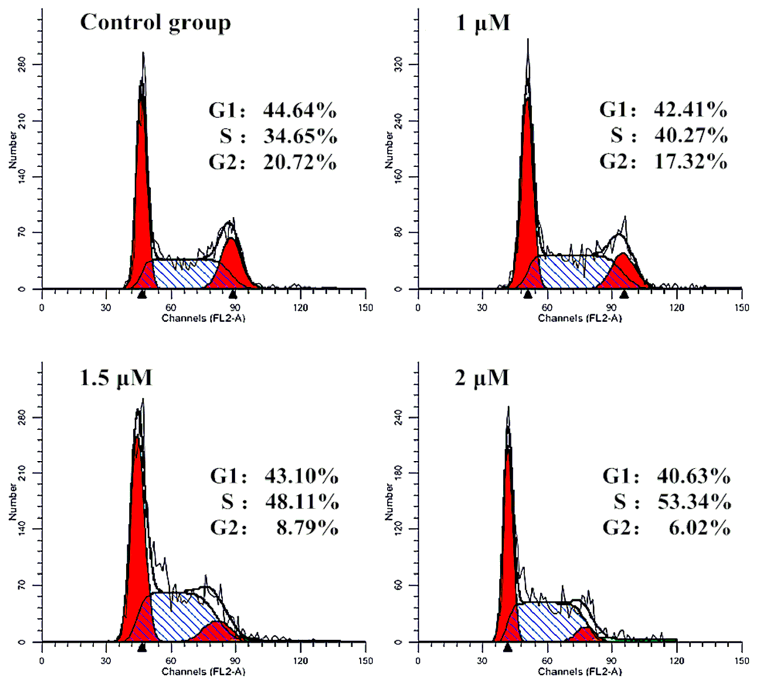
Figure 4. Influence of the cell cycle arrest of S phase by 10f in Bel-7402 cells: Bel-7402 cells were incubated with the indicated concentrations of 10f for 24 h and the cells were stained with propidium iodide (PI). Cellular DNA content, for cell cycle distribution analysis, was measured using a flow cytometer. The diagrams show the distribution of the cells according to their DNA content. The inserts give the percentages of cells in different cell cycle